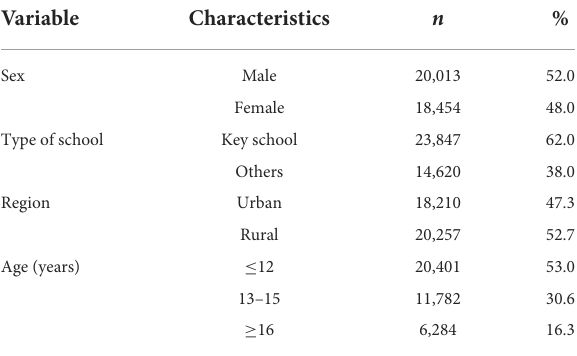
TABLE 1 Characteristics of the study